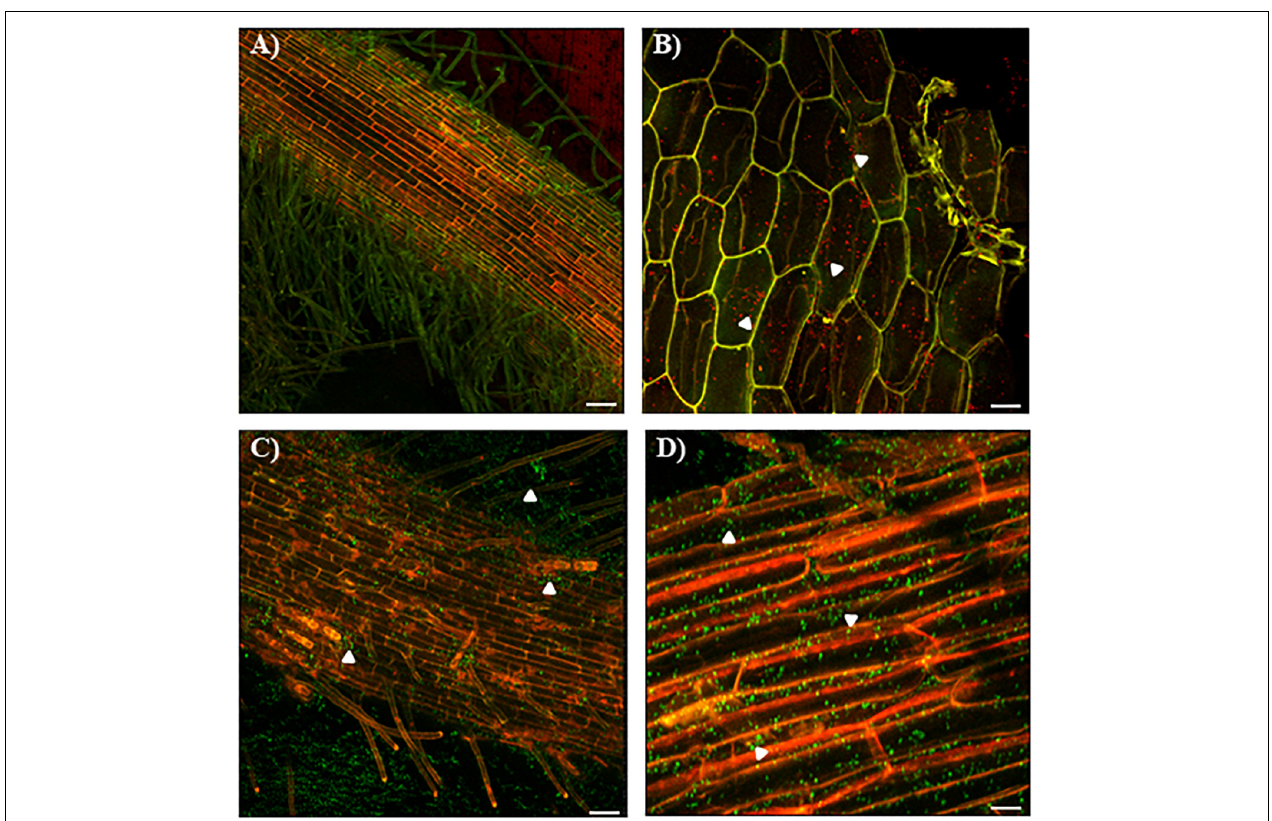
FIGURE 6 | Confocal images of colonization of wheat roots by CLSM. (A) Colonization pattern of the mCherry-tagged A. baldaniorum 2449 in wheat roots after 7 days of inoculation. Typical endophytic behavior of the wild-type strain. (B) Wild-type strain (red fluorescence) location was corroborated through a longitudinal cut of wheat root. White arrowheads indicate mCherry-expressing A. baldaniorum 2449 strain. The images (A,B) represent the merge of two micrographs of mCherry detection (shown in red) and plant autofluorescence (shown in green). (C) Colonization pattern of the eGFP-tagged A. baldaniorum 2450 in wheat roots after 7 days of inoculation, showing an alteration in its ability to internalize, locating outside of wheat root. (D) Surface colonization pattern of A. baldaniorum 2450 expressing eGFP in wheat roots after 7 days of inoculation, indicated with arrowheads. Magnification 10X. The images (C,D) represent the merge of two micrographs of eGFP detection (shown in green) and plant autofluorescence (shown in red). Bars represents 50 µ m. Representative images were acquired by examination of several images with a 20X objective, and 1.8 amplification